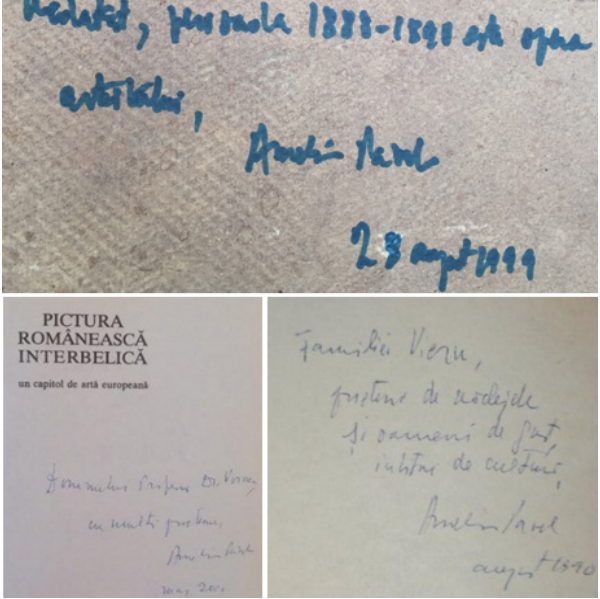
Figure 11. Comparative analysis of Amelia Pavel’s signature.